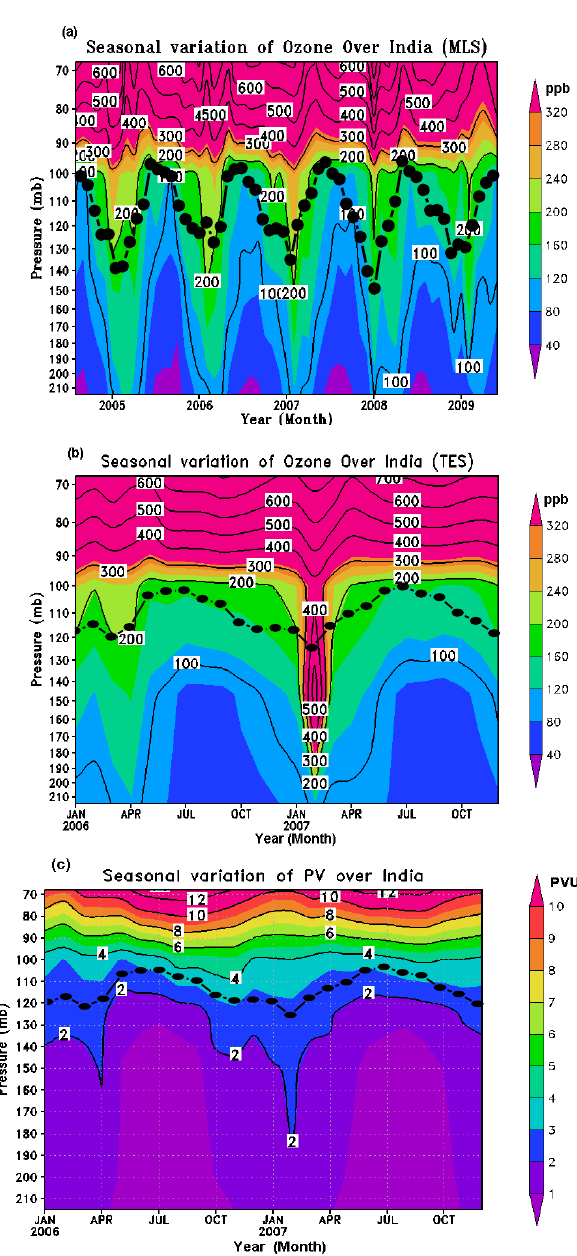
Fig. 1. (a) Vertical variation of monthly mean ozone mixing ratio (averaged over the Indian region) in the upper troposphere as ob- tained from MLS satellite data during August 2004 to June 2009. (b) Vertical variation of ozone mixing ratio (averaged over the In- dian region) in the upper troposphere as obtained from TES satellite measurements during 2006–2007. (c) Vertical variation of potential vorticity (averaged over the Indian region) in the upper troposphere as obtained from ECMWF analyses during 2006–2007. Thick black line with dots indicates tropopause